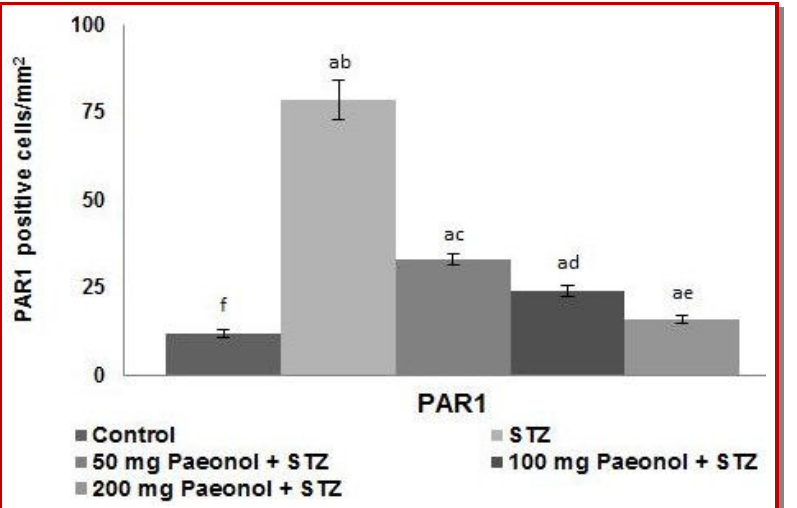
Figure 7 (Cont.): Antioxidant and anti-inflammatory effects of paeonol. Paeonol effectively down-regulated expressions of NF- κ Bp65 and p-I κ - B α in the cardiac tissues (A and B), reduced serum levels of inflammatory mediators (C) and decreased serum ROS levels (D) Values are represented as mean ± SD, n=6. a represents statistical significance at p<0.05 compared against respective controls and b-f represents significant difference (p<0.05) between mean values within the groups as determined by one-way ANOVA followed by DMRT analysis (L1-Control; L2-streptozotocin; L3-50 mg paeonol + streptozotocin; L4-100 mg paeonol + streptozotocin; L5-200 mg paeonol +